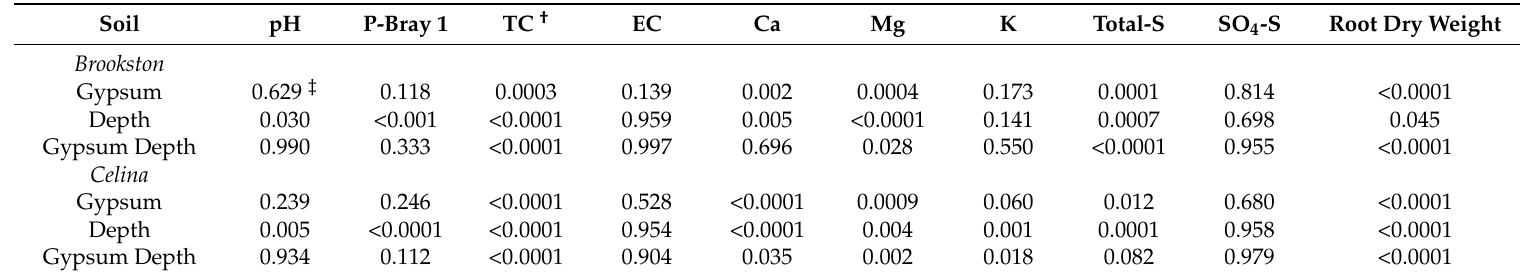
Table 1. Probability levels for testing of treatment effects calculated from analysis of variance of alfalfa root dry weight and chemical properties of two Ohio soil series treated with three levels of gypsum.